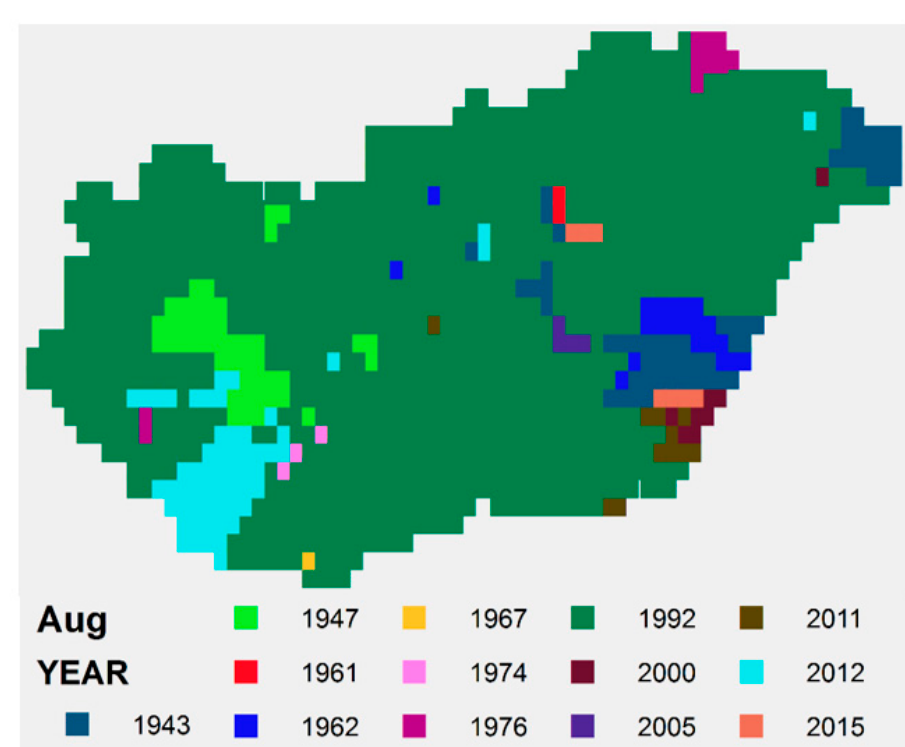
Figure A13. August: Year of maximum SPTI values, 1871–2020.